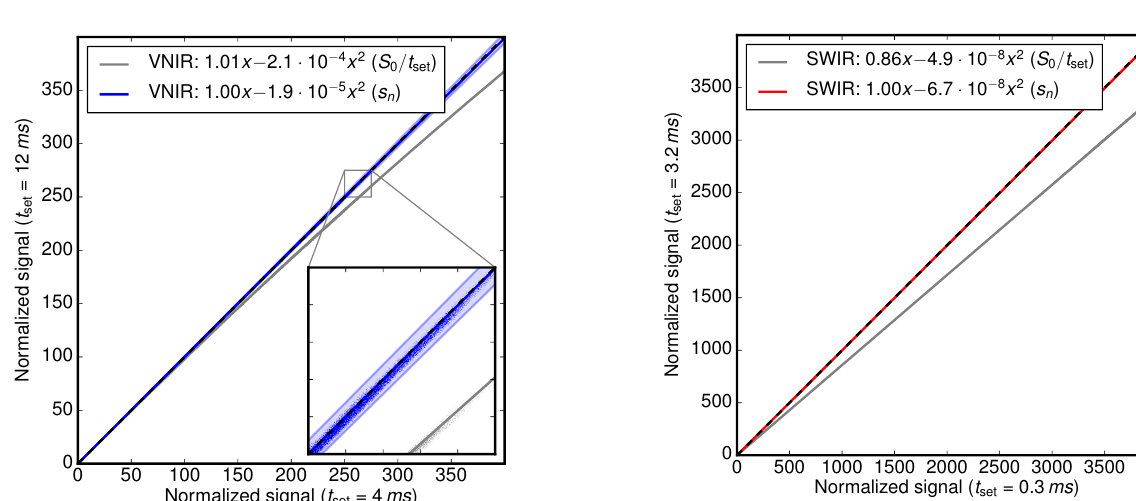
Figure 7. Integration time-normalized signal S 0 /t set (gray line) of the stabilized light source (LIS), measured with the VNIR using two different integration times t set = 4ms and t set = 12ms. The blue line shows the signal after nonlinearity correction ( s n ) with the re- maining nonlinearity uncertainty shown by the blue filled area. The dashed line represents the response of a perfectly linear sensor fol- lowing Eq. (7).